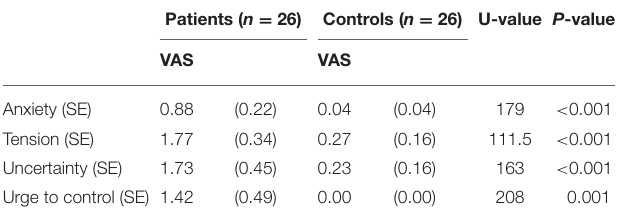
TABLE 3A | Emotional responses at baseline.